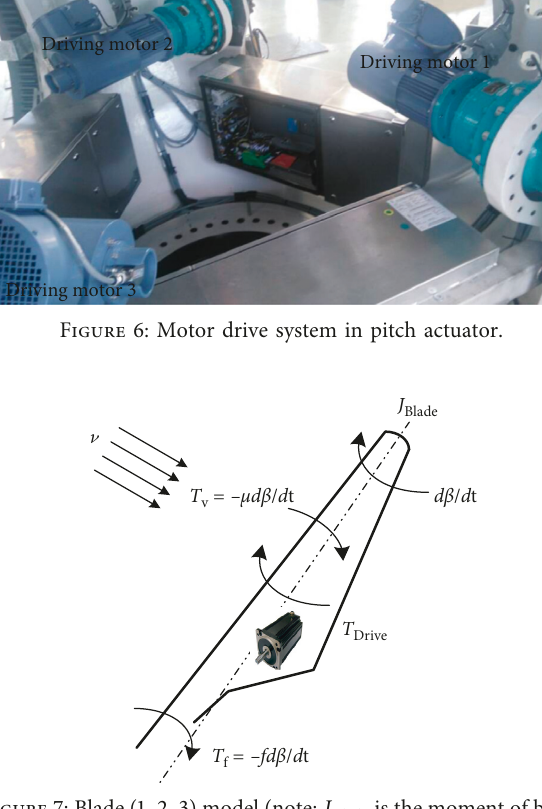
Figure 10: Dynamic model of transmission chain (remark: Sun and Figure 7: Blade (1, 2, 3) model (note: J Blade is the moment of blade Sate represent the sun wheel and planetary gear of inertia. T Drive is the motor-driving torque. T v is the resistance torque of wind. T f is the resistance torque of blade root friction. f and μ are the coefficient of friction of blade root and wind drag, respectively).